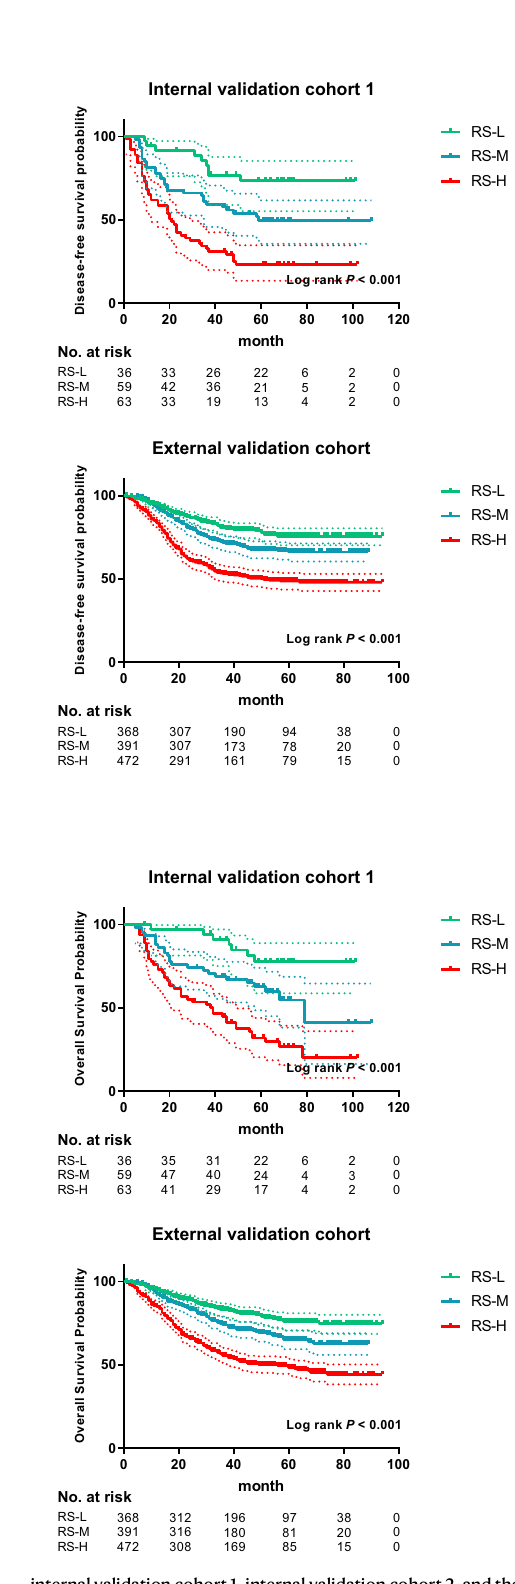
Fig. 4 | Kaplan – Meier analyses of disease-free survival (DFS) and overall sur- vival (OS) according to different RS groups in patients with gastric cancer. a Disease-free survival according to different RS groups in the training